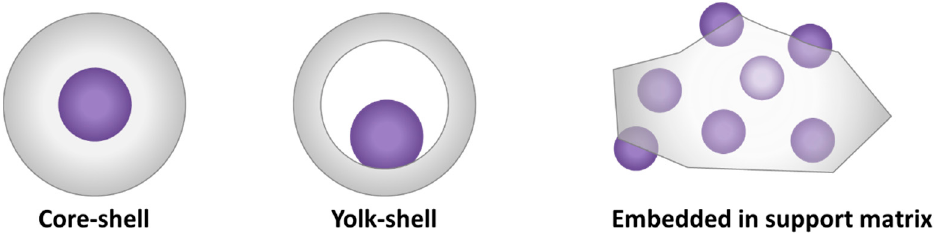
Figure 9. Common “embedded” NP catalyst architectures. Purple denotes the active phase, grey the support phase.